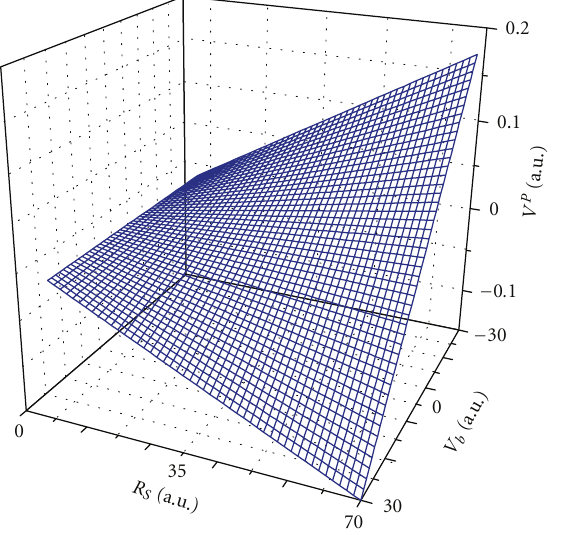
Figure 4: Three-dimensional plot for V P as a function of R S and V b